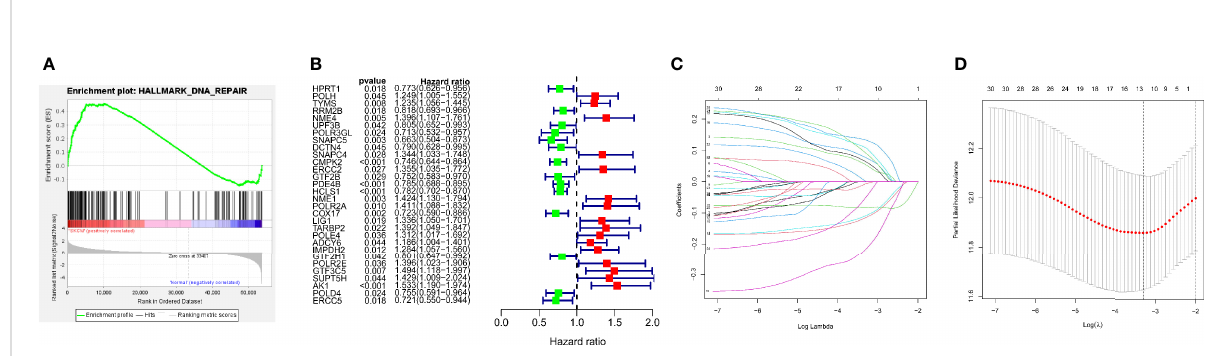
FIGURE 2 Construction of DRRGs signature. (A) Signi fi cant enrichment of DNA repair-related pathways in SKCM patients. NES, normalized enrichment score; (B) The forest plot of the univariate Cox regression depicted 30 DRRGs associated with SKCM survival; (C) Lasso regression for DRRGs in univariate Cox regression; (D) Coef fi cients of selected features denotes the risk coef fi cient is shown by lambda